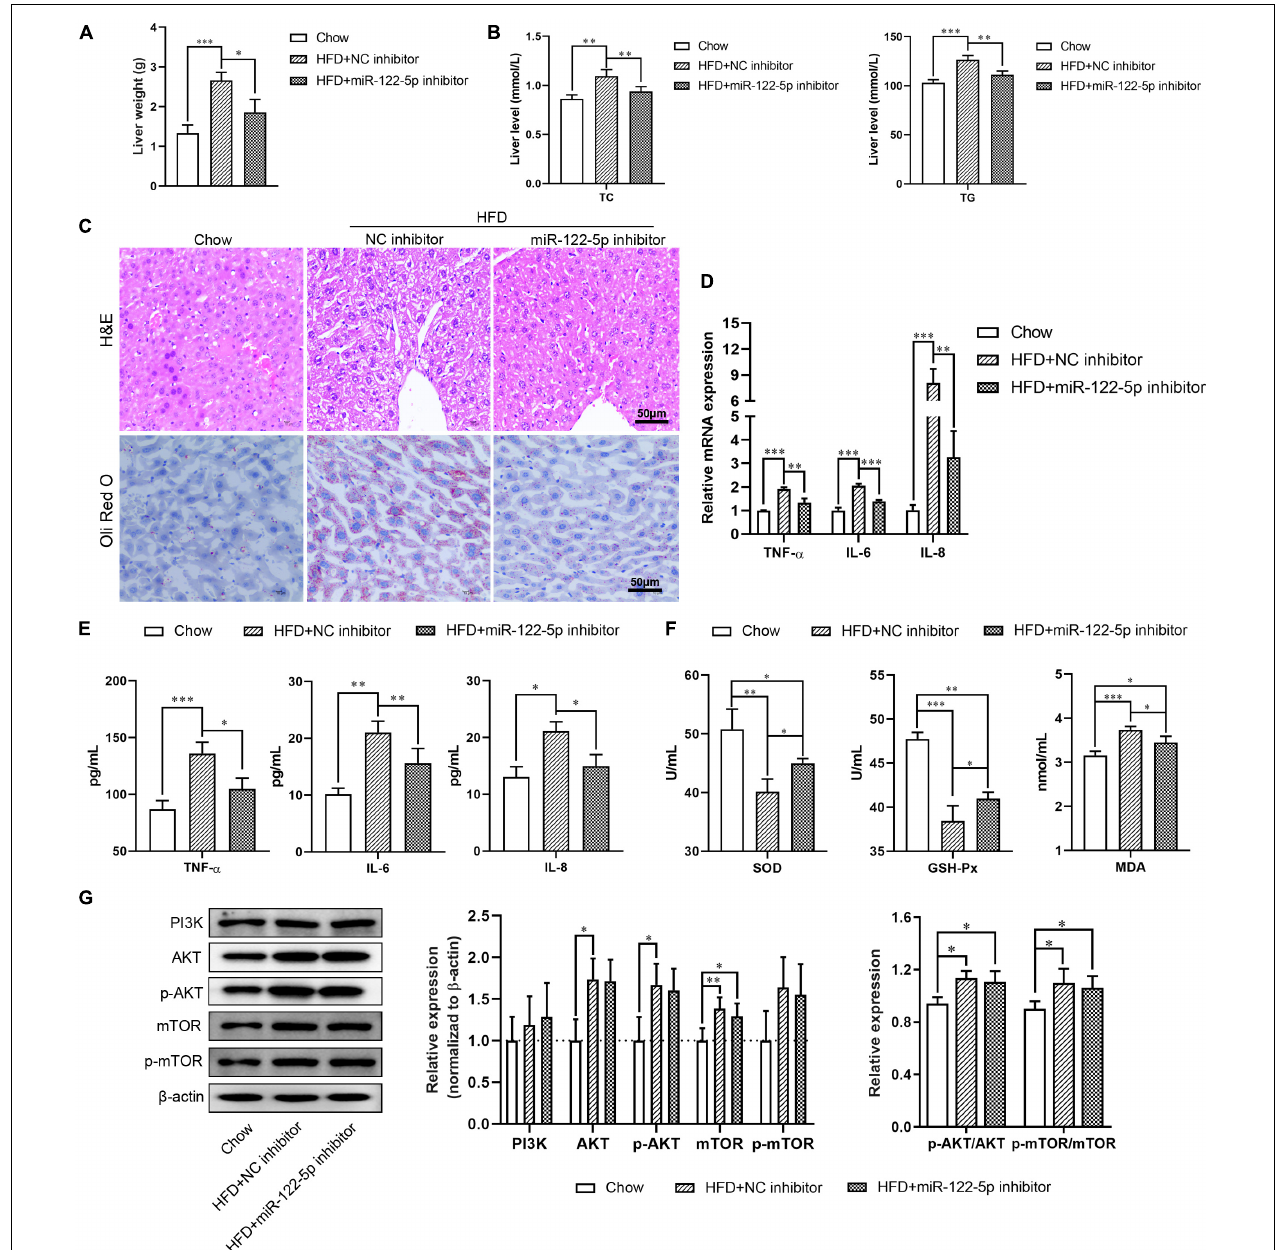
FIGURE 3 | Suppression of miR-122-5p improves HFD-induced oxidative stress injury in fatty liver disease. (A) HFD-fed mice were injected with lentivirus encoding miR-122-5p antisense (miR-122-5p inhibitor) or nonsense (NC inhibitor) for 4 weeks, then the liver weight was measured. (B) Hepatic TC and TG. (C) Liver morphological characteristics were observed by H&E and Oli Red O staining after injected with miR-122-5p or NC inhibitor. (D) RT-qPCR analyzed the expression of TNF- α , IL-6, and IL-8. (E) ELISA analyzed the level of TNF- α , IL-6, and IL-8 in liver tissue. (F) The activity of SOD and GSH-Px, and the content of MDA. (G) Western blot analysis of PI3K, AKT, p-AKT, mTOR, and p-mTOR expression. Error bars indicate SD. ∗ P < 0.05, ∗∗ P < 0.01, ∗∗∗ P <